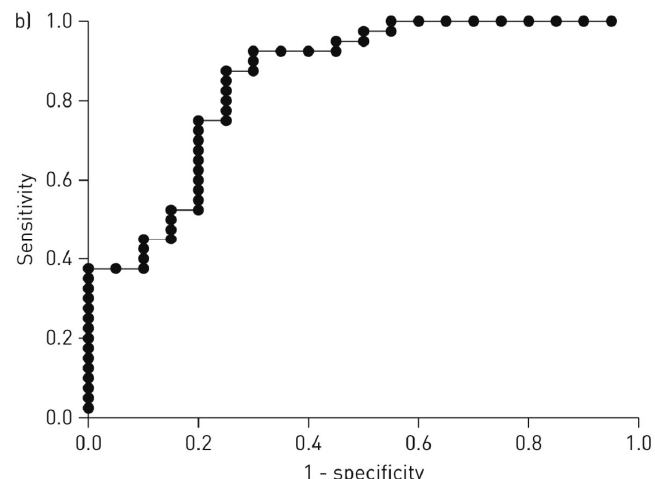
Figure 13. ( a ) Linear discriminant analysis of sleep apnoea patients and healthy controls differ statistically significantly. ( b ) The area under the receiver operating characteristic curve equals 0.85, resulting in a sensitivity of 0.93 and a specificity of 0.70. OSAS: obstructive sleep apnoea syndrome; HC: healthy control. #: p < 0.0001, Mann–Whitney U-test. Used with permission from [92].